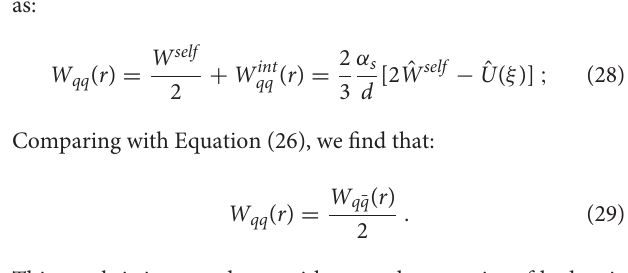
Frontiers in Physics |